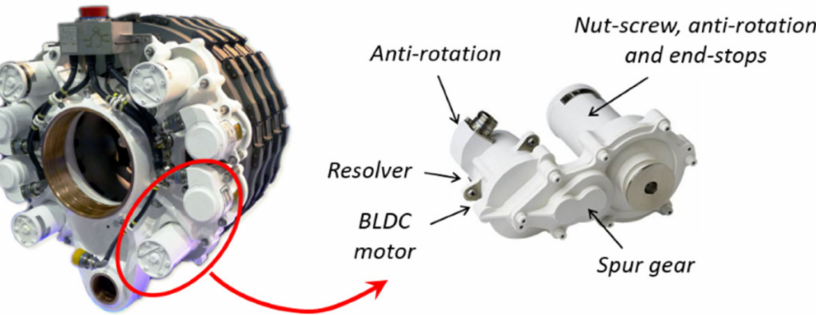
Figure 7. Electric brake actuators of Boeing